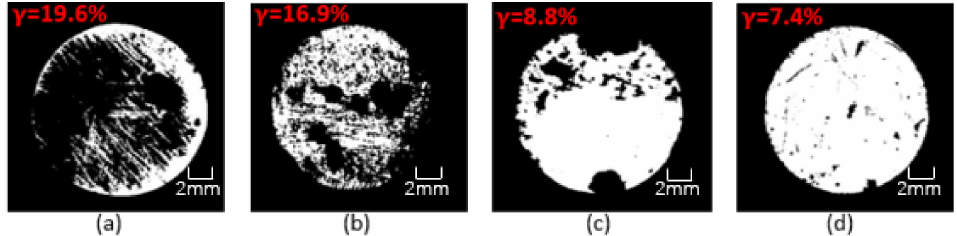
Figure 17. Binary image of each coating in seawater of 20% concentration for 60 days: ( a ) G1; ( b ) G2; ( c ) G3; ( d ) G4.